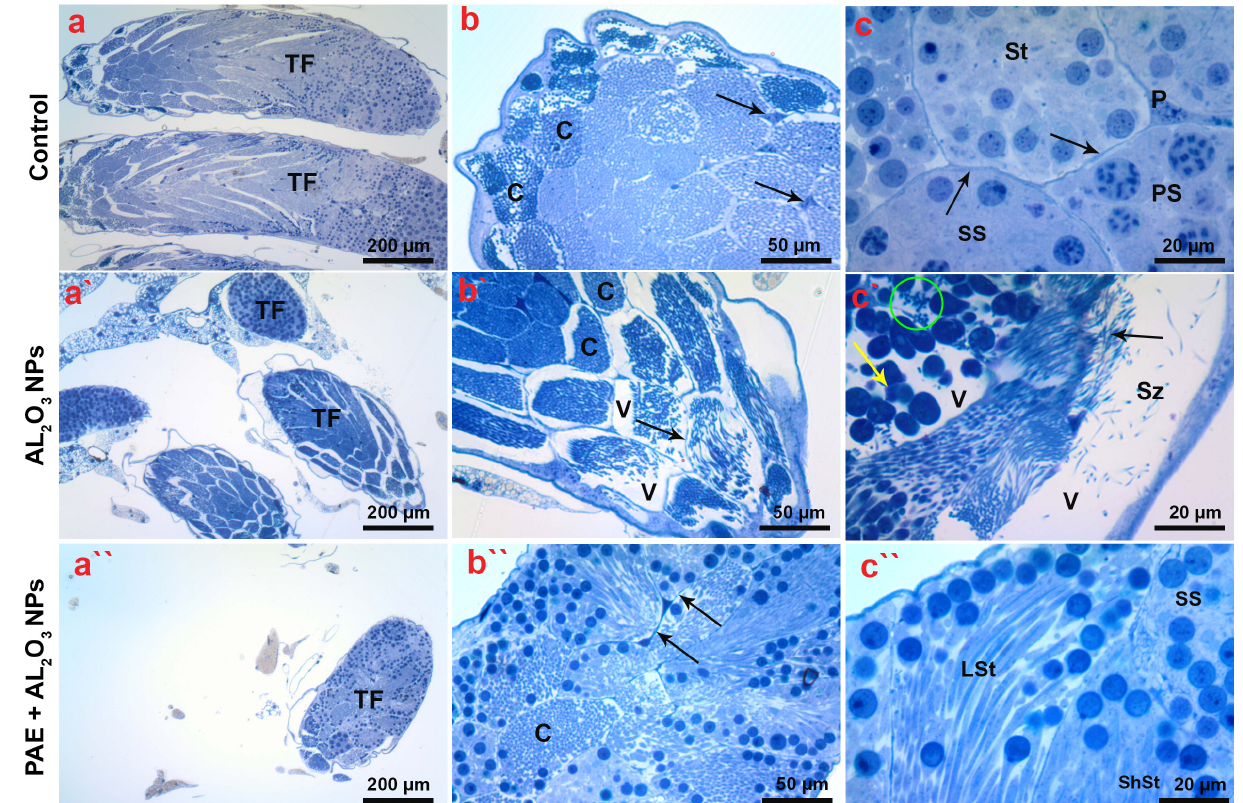
Figure 12. Photomicrographs of semithin sections show the histological structures of the testicular follicles (TF) of the locust after Al 2 O 3 NPs injection with or without PAE treatment. Semithin sections through the TFs of the control, Al 2 O 3 NPs, and PAE + Al 2 O 3 NPs groups are given in ( a ), ( a ` ) and ( a `` ), respectively, showing shrinkage in the size of follicles in the Al 2 O 3 NPs- and PAE + Al 2 O 3 NPs-treated groups compared to the control. Figure ( a ) illustrates the typical structure of the TFs in the control group. Figure ( a ` ) shows a shrinkage of follicular size in the Al 2 O 3 NPs-treated group. Figure ( a `` ) exhibits normal TF similar to that of the control group. Figures ( b – b `` ) show the dif- ferent cysts (C) within the TFs and parietal cells in between (arrows) in the control, Al 2 O 3 NPs-, and PAE + Al 2 O 3 NPs-treated groups, respectively. Figure ( b ) illustrates typical follicular cysts of various spermatogenic stages. Figure ( b ` ) shows obvious vacuolation (V) in the cysts of the Al 2 O 3 NPs-exposed group. Figure ( b `` ) demonstrates normal follicular cysts at different developmental stages with intact cyst walls (arrows). Figure ( c ) shows typical spermatogenic elements, indicating different developmental stages, including primary spermatocyte (PS), secondary spermatocyte (SS), and spermatid (St). Besides this, normal parietal cells (P) and cyst walls (arrows) could be perceived. Figure ( c ` ) shows the rupture of cyst walls (black arrow), vacuolation (V), dense vesicles (yellow arrow), spermatozoa (Sz) in the follicle lumen, and dense particles (green circle). Figure ( c `` ) ex- hibits regular spermatogenic elements, implying normal developmental stages, including secondary spermatocyte (SS), short spermatid (ShSt), and long spermatid